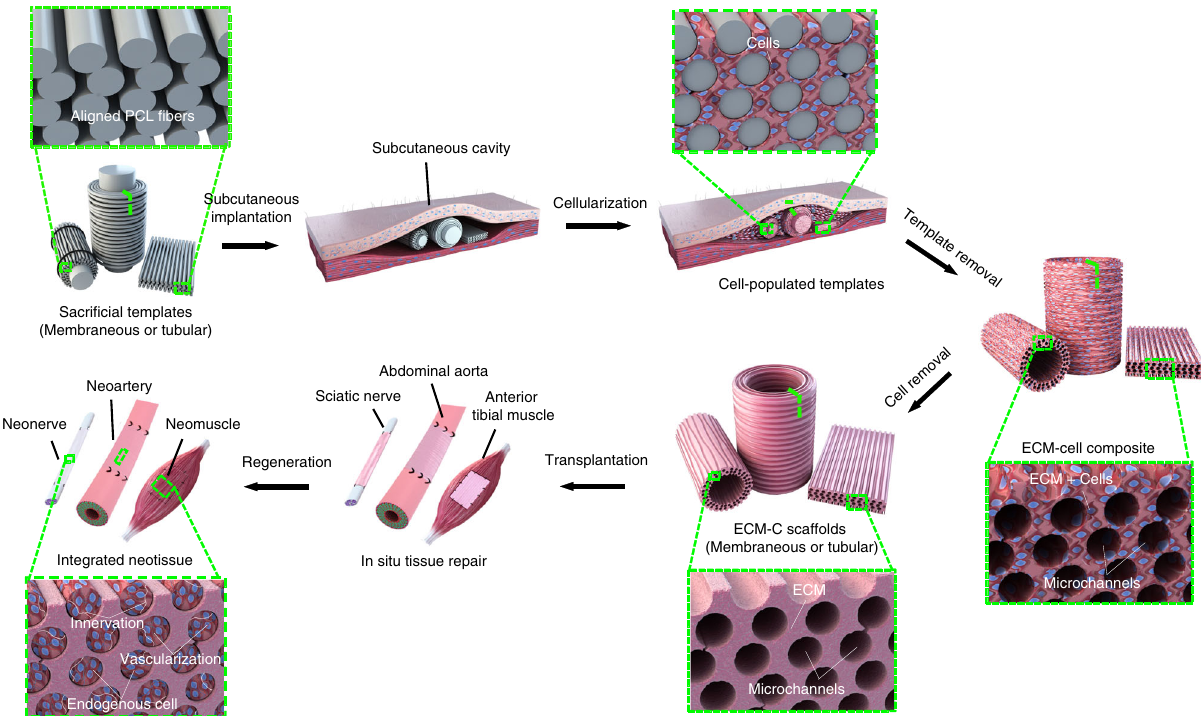
Fig. 1 Sketch map of generation and application of ECM scaffold. Schematic illustration of the key steps leading to the formation of ECM scaffolds with aligned microchannels for demonstrated utility in guided regeneration of muscle, nerve and